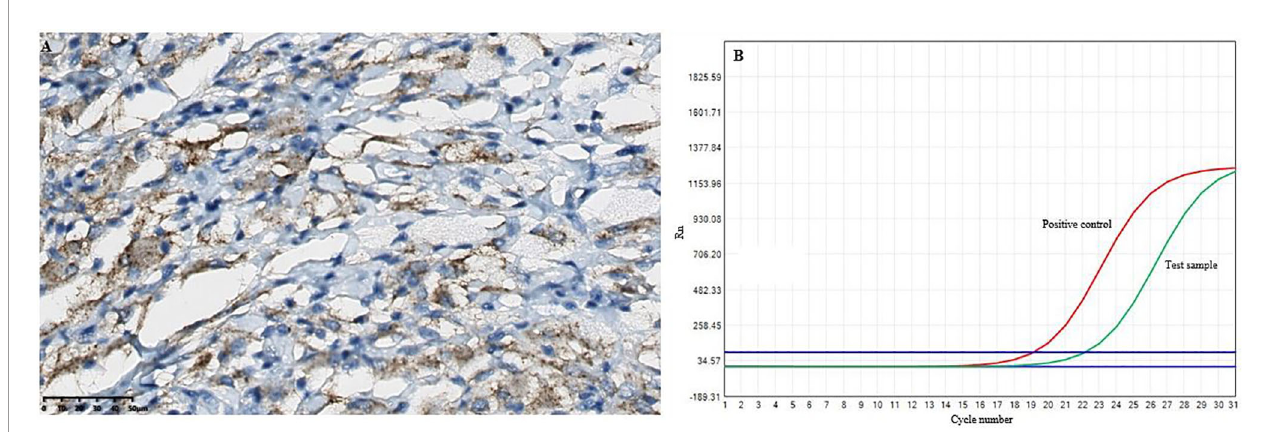
FIGURE 4 | The results of the BRAF V600E mutations in the intracranial lesion tissue. (A) Immunohistochemical BRAF V600E staining showed positive tissue cells (scale bar is 200/50 m m). (B) and the BRAF V600E mutations was detected by